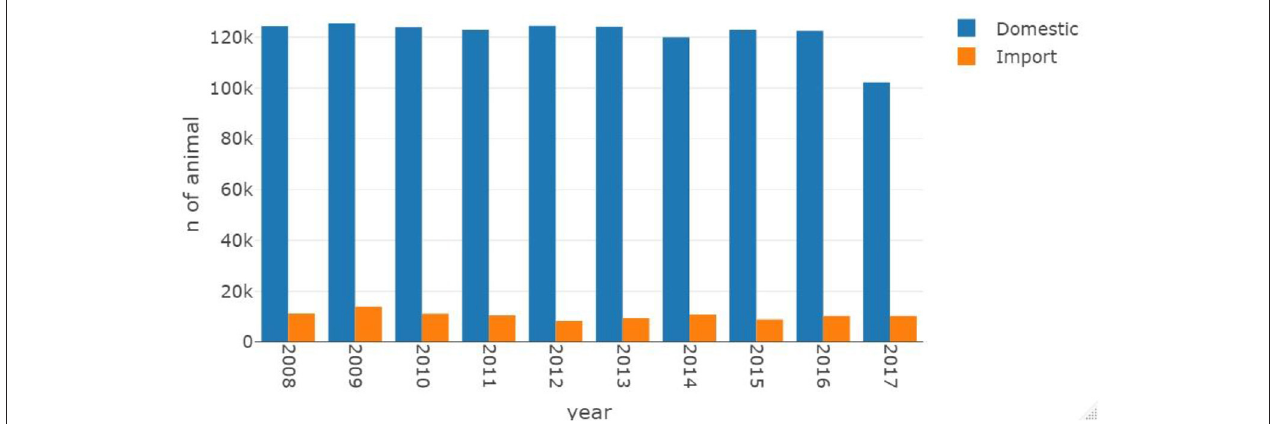
FIGURE 3 | Movement frequency from 2008 to 2017 in Scotland. The color in blue showed domestic movement frequency, animals depart and arrive from farm in Scotland. While the orange showed import movement frequency, animals originated not from Scottish farms. direction of the situation significantly. This also illustrates how animal importations drive the PI